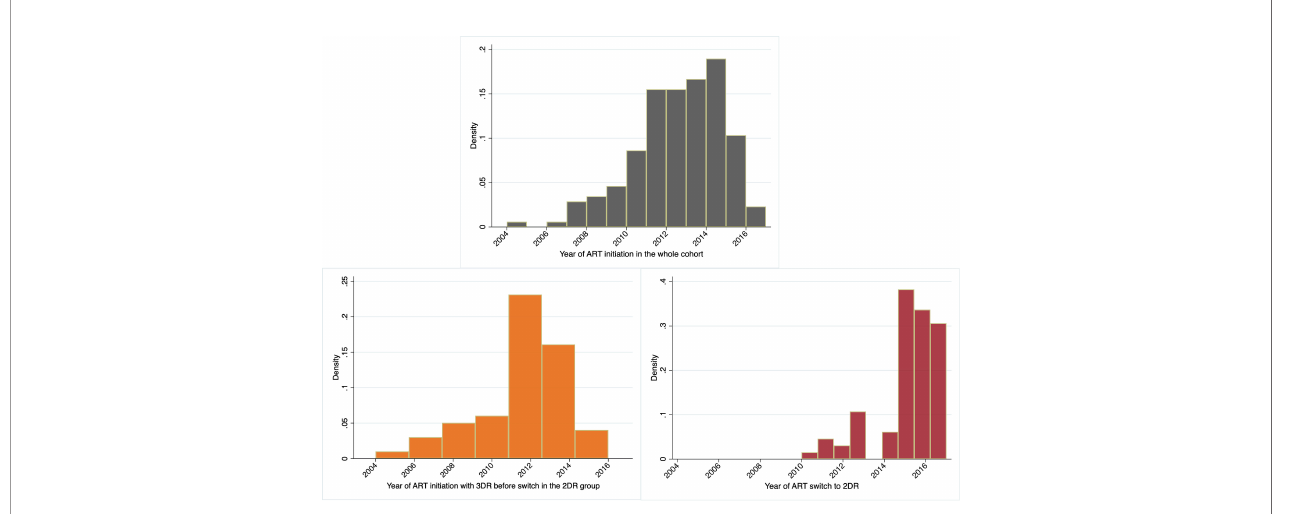
FIGURE 1 | The histograms depict the percentage of participants initiating ART in the whole cohort, the 2-drug regimen group (2DR), and the year of ART switch in the 2DR